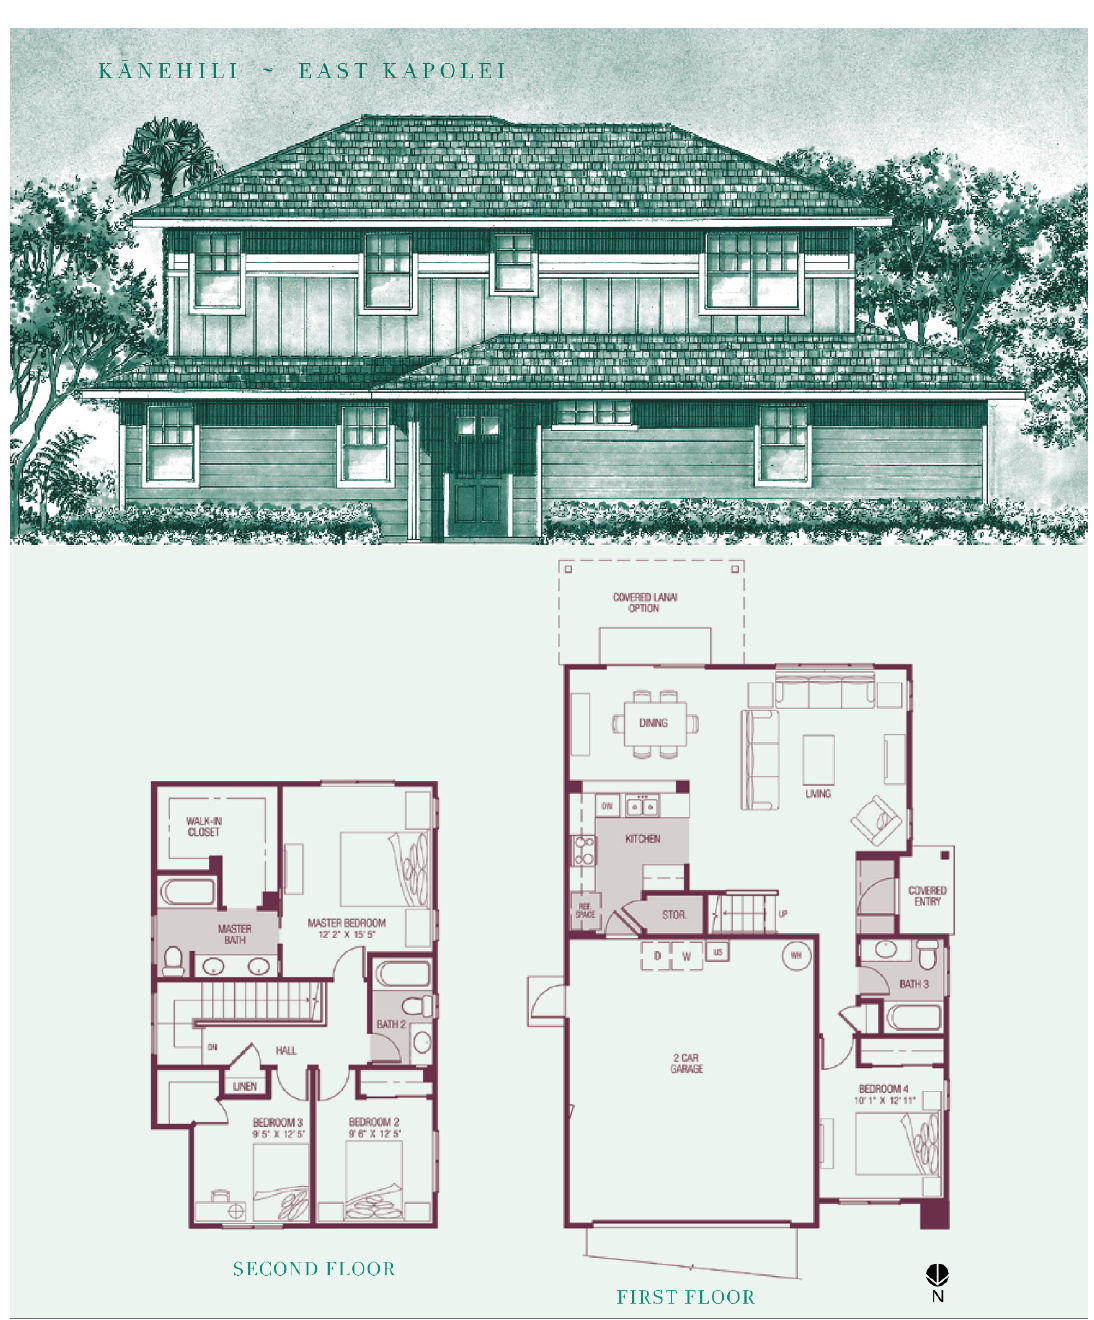
Figure 1. Elevation (top) and floor plans (bottom) for House #3 and House #4. Modified from copyrighted image from Gentry Kapolei Development, LLC, 2008.